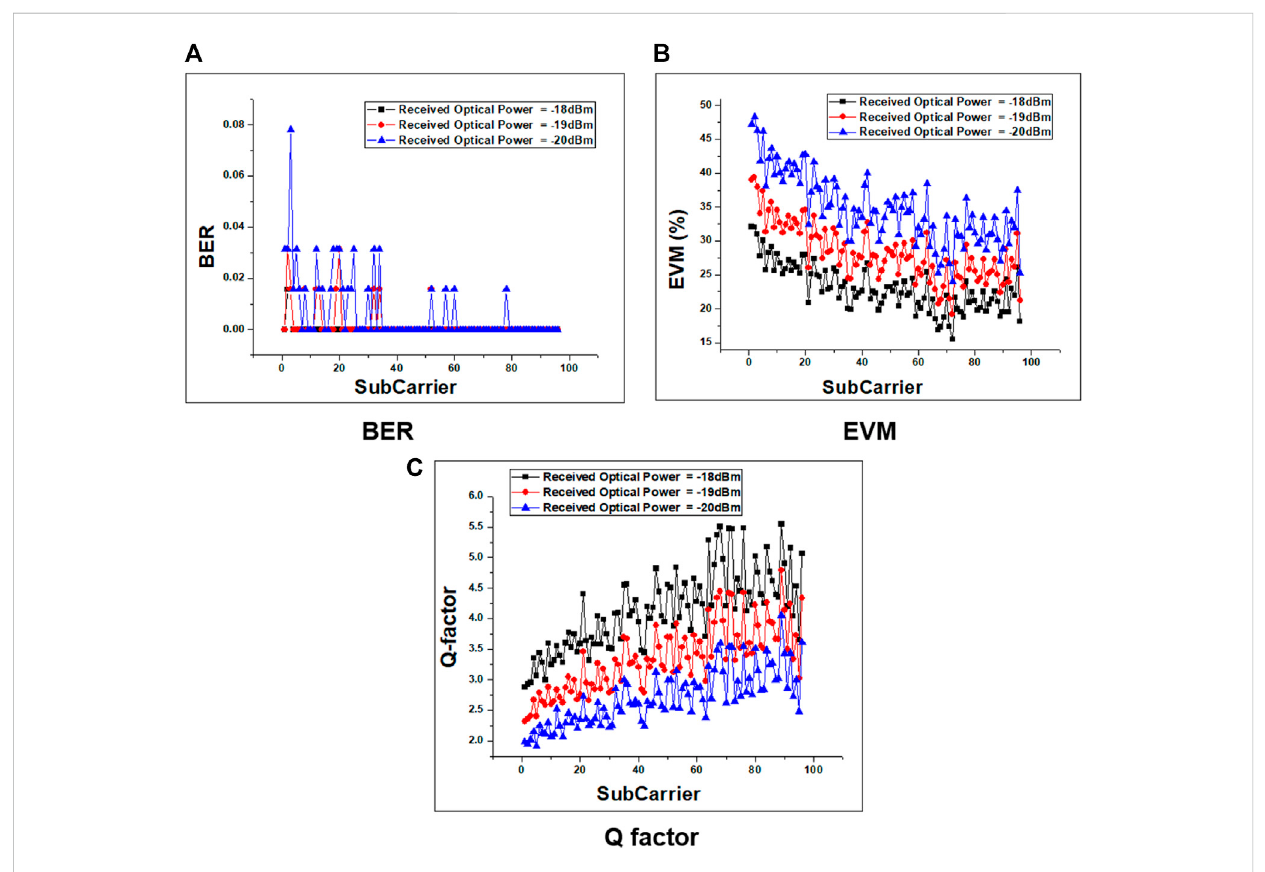
FIGURE 6 BER, EVM, and Q-factor distributions on each data sub-carrier. (A) BER distributions; (B) EVM distributions; (C) Q-factor